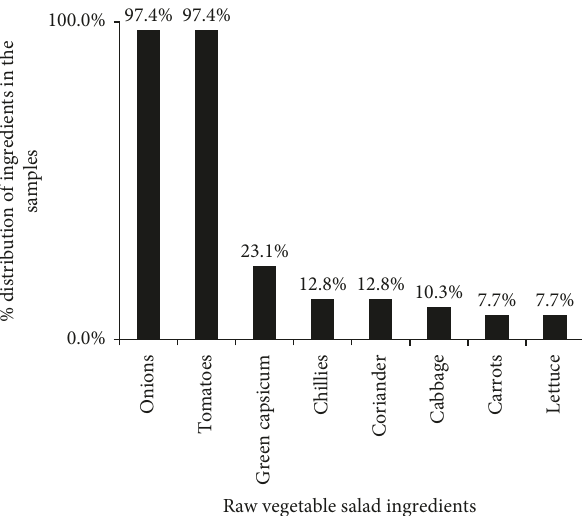
Figure 3: Vegetables used in kachumbari raw salads served by roast meat eateries ( n � 39).